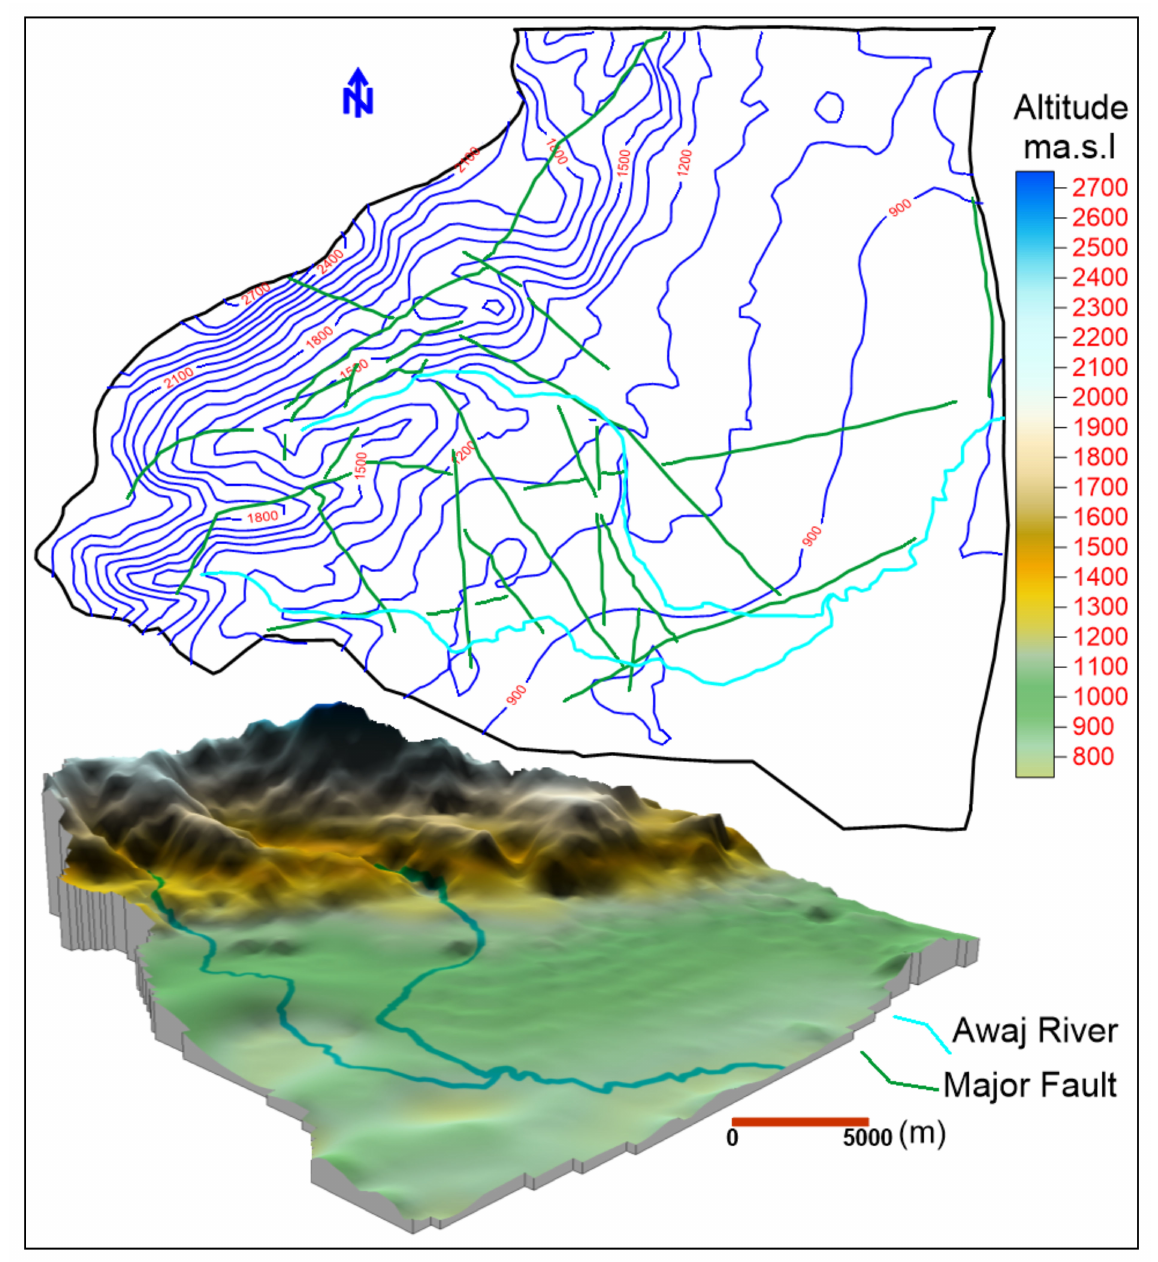
Figure 5. Major faults that depicted in the study area (after [30,31]) together with elevation contours as well as the DEM of this